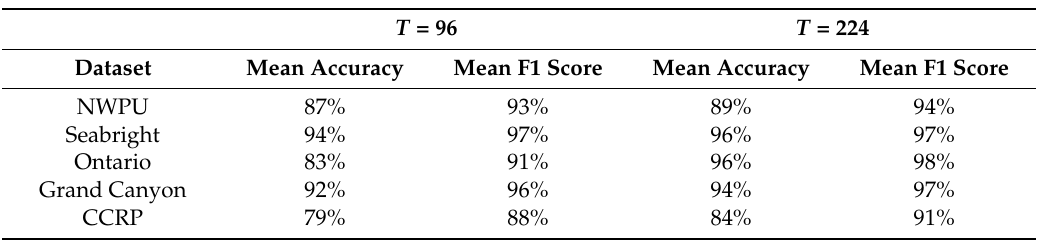
Table 1. Whole tile classification accuracies and F1 scores for each dataset and tile size, using the test tile set not used to train the model.